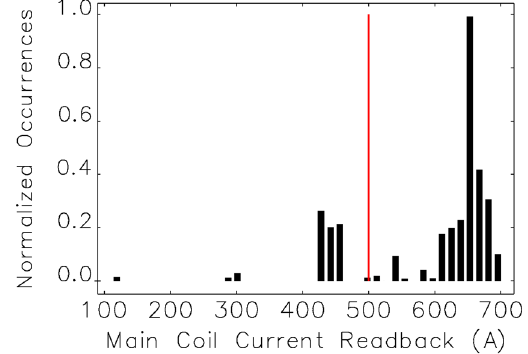
FIG. 14. Histogram showing the SCU0 magnet operational current normalized to the most frequent occurrence (design current is marked).